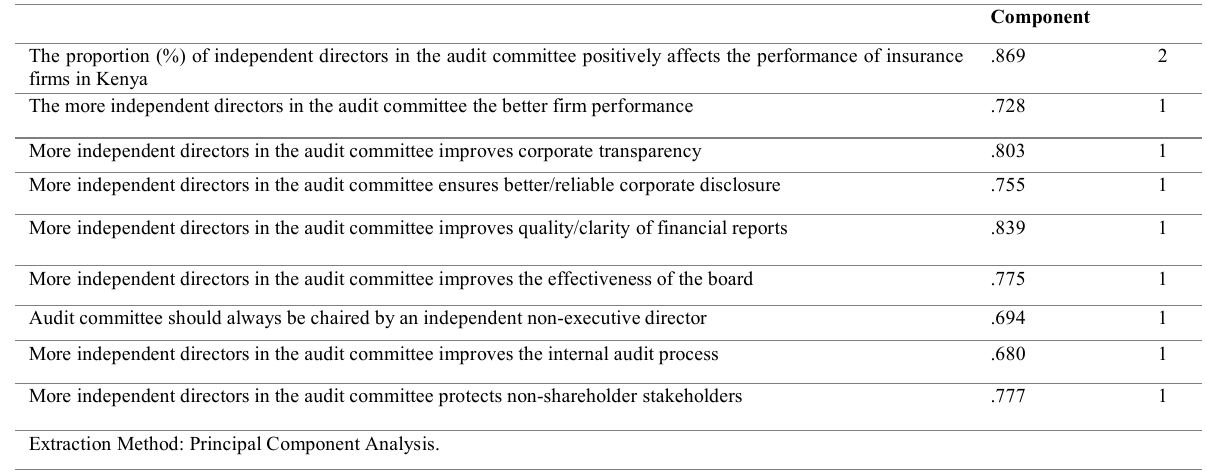
Table 6 : Component Matrix for Audit Committee Independence